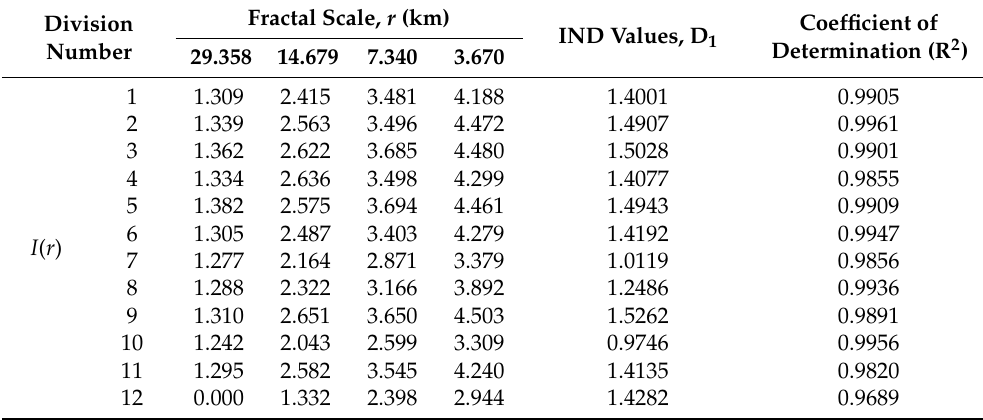
Table 4. Statistical table of division for the information dimension (IND) calculation parameters.